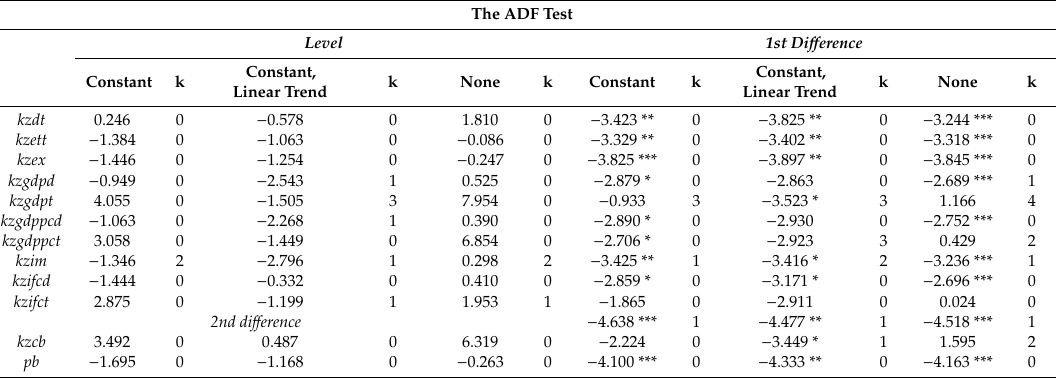
Table A23. KZ. The Unit Root test results.